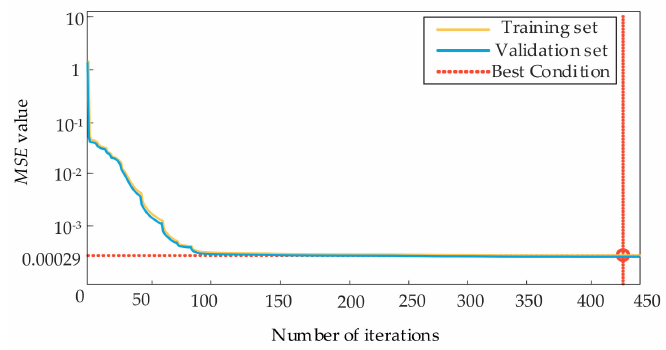
Figure 10. The change curve of MSE value during the training of the location